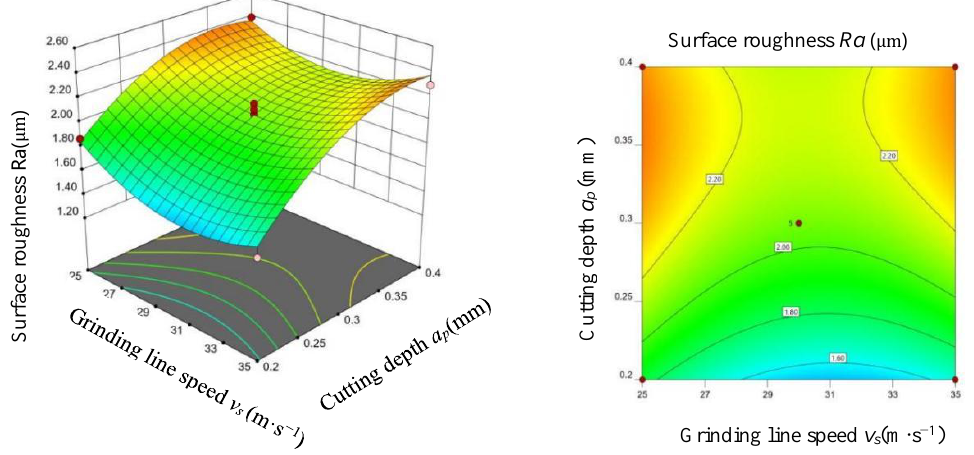
Figure 7. Cutting depth–grinding line speed response surface and contour map.